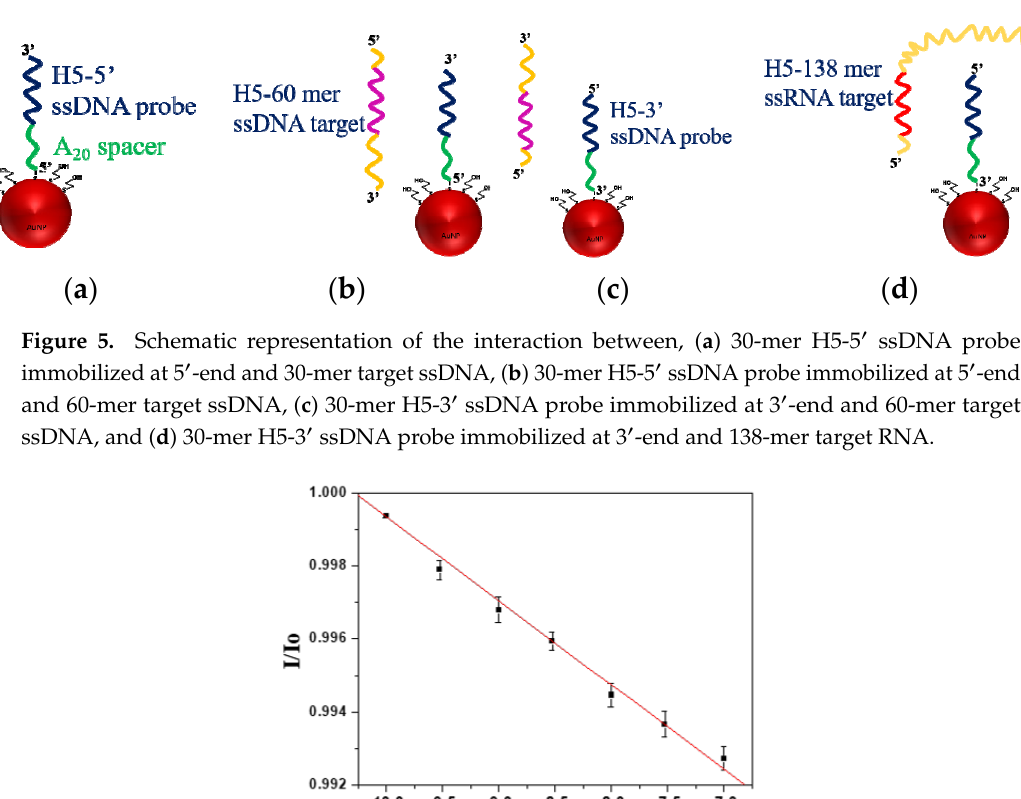
Figure 7. A typical real-time FOPPR sensorgram with H5-5’ ssDNA probe to detect 60-mer target ssDNA at a concentration of 1.0 × 10 –6 M.